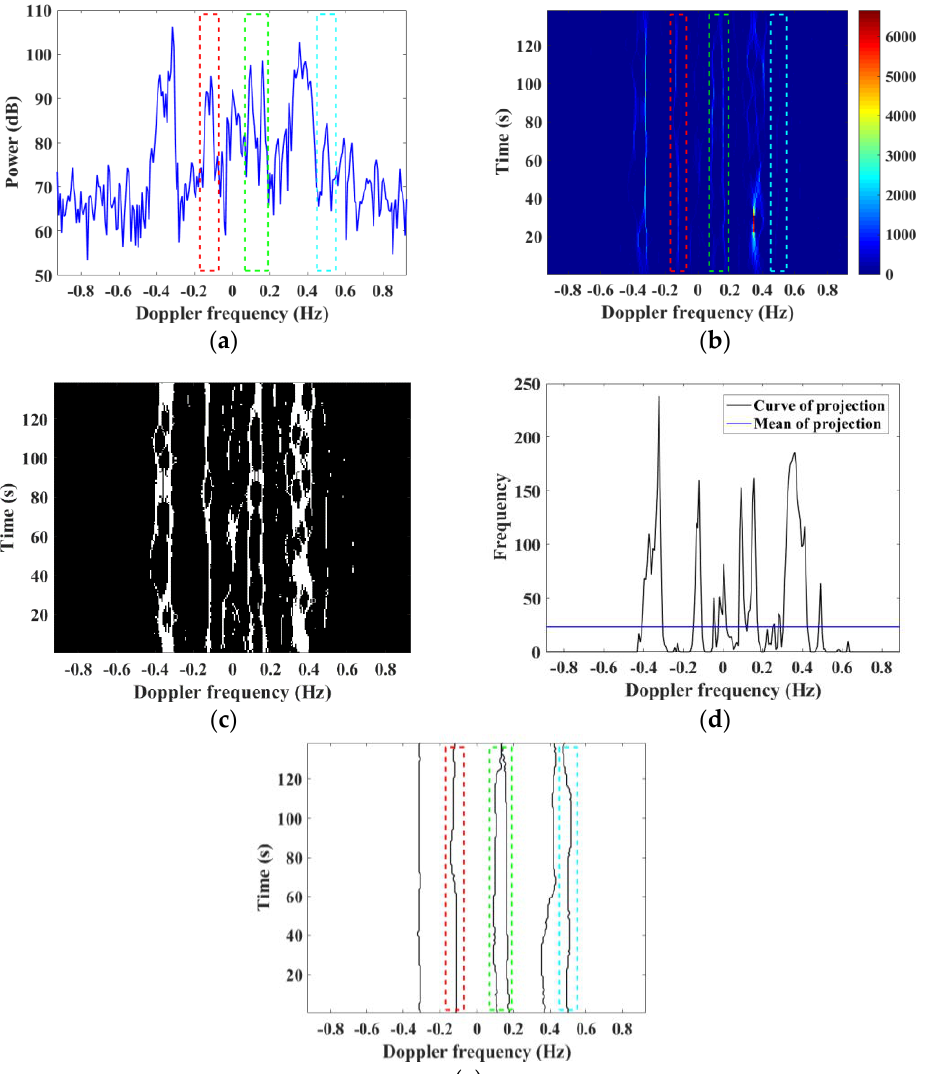
Figure 4. Power spectrum, TFR and binarization processing of radar echo signal at 7th range bin at 06:51 on 25 September 2015. ( a ) power spectrum; ( b ) TF image; ( c ) binary grayscale image of the TF image; ( d ) vertical projection of the binary grayscale image; and ( e ) extraction of TF ridges at the 7th range bin.